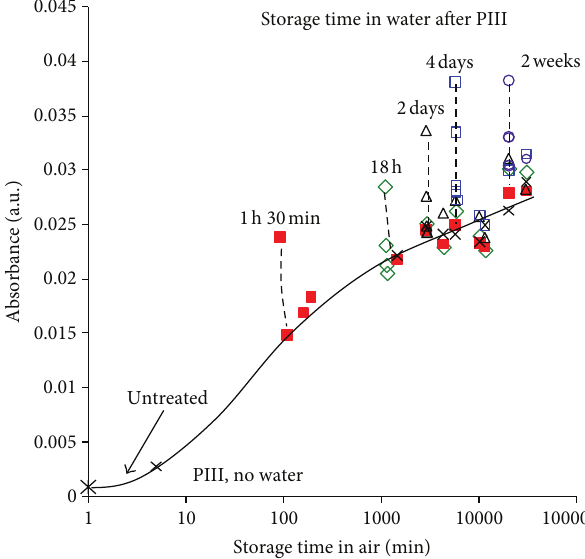
F 8: Normalized absorbance intensity due to hydroxyl groups line of −1 carbonyl line O) normalized to the 2917cm )inFTIRATRspectraofUHMWPEasafunctionoftime (3400cm −1 of storage aer PIII treatment. e time of storage under water is −1 shownannotatedinthe�gure.Whenthesampleistakenfromwater, the adsorbed water in gives a contribution in the intensity of line. Aer 30–40mins the water